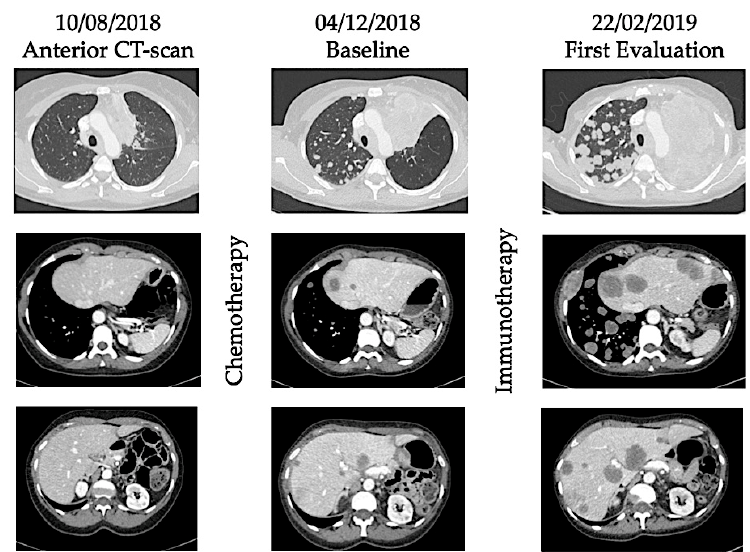
Figure 2. Illustration of hyperprogression under immunotherapy. A 53-year-old female patient with metastatic (lung) submandibular gland epidermoid carcinoma was treated in third line with weekly Methotrexate. After 4 months, patient experienced disease progression with appearance of lung, hepatic, and bone metastases. As fourth line, she received Nivolumab, an anti-PD-1 inhibitor. After 4 injections, she presented with major dyspnea with massive disease progression on computed-tomography (CT) scan. She died 64 days after immunotherapy initiation.